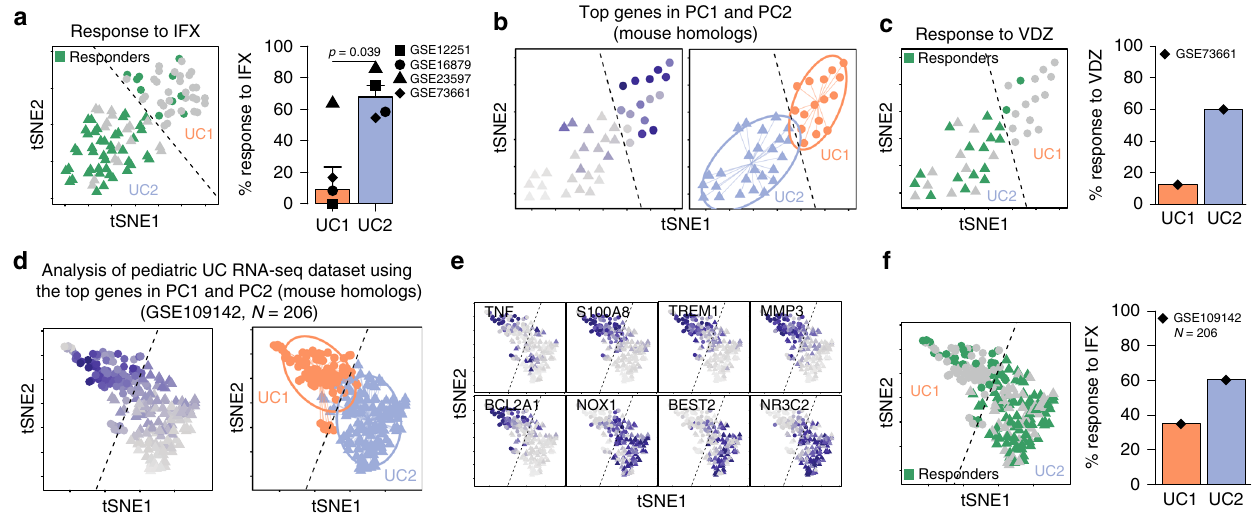
Fig. 5 UC1 and UC2 differ on their response to IFX and VDZ therapy. a Individual patient response to IFX therapy in each group and the percentage of patients responding to IFX in each cohort. b t-SNE plot using the top variable genes identi fi ed from the mouse data set. Average expression of mouse homolog genes used to subdivide patients (left), where dark blue color indicates a higher average expression. Unsupervised hierarchical agglomerative clustering was used to automatically de fi ne patient subdivision (right). Dashed line delimits UC1 (triangle) and UC2 (circles) patients. c Individual patient response to VDZ therapy in each group and the percentage of patients responding to VDZ in the cohort (right). d t-SNE for data set GSE109 containing 206 pediatric UC patients plot, using the top variable genes identi fi ed from the mouse data set. Each point represents a patient sample. The average expression of mouse homolog genes used (left) to subdivide patients into UC1 or UC2 (right). Unsupervised hierarchical agglomerative clustering was used to automatically de fi ne patient subdivision (right). Dashed line delimits UC1 (triangle) and UC2 (circles) patients. e t-SNE overlay of the expression level of selected DEGs between UC1 and UC2, showing inter-patient variation in the pediatric UC cohort. f Individual patient response to IFX therapy in each group and the percentage of patients responding to IFX in each